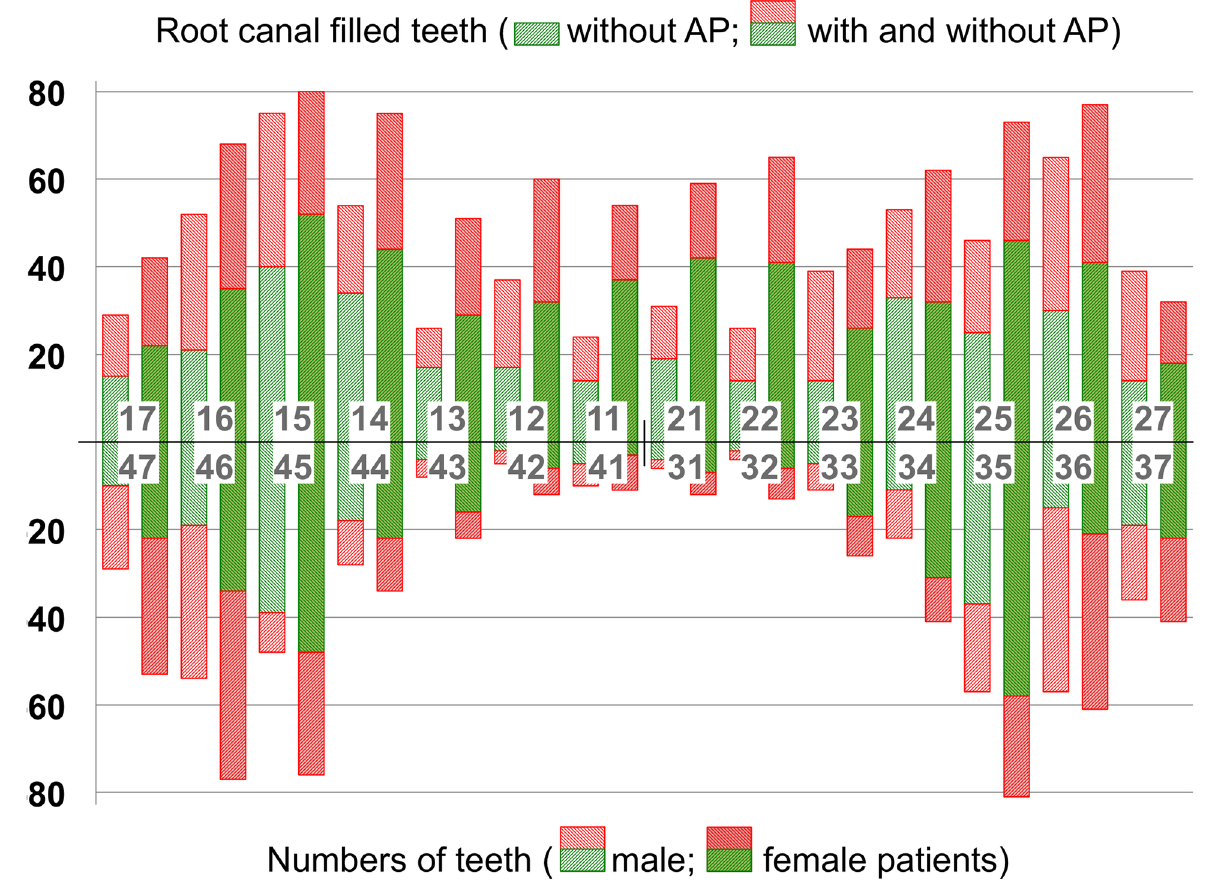
Fig 1. Distribution of apical pathosis (AP). Distributionis given by type of tooth, by jaw, and by genderfor all root canal filled teeth (n = 2,373; note that total number of teeth representsunequivocal scores of the evaluators).